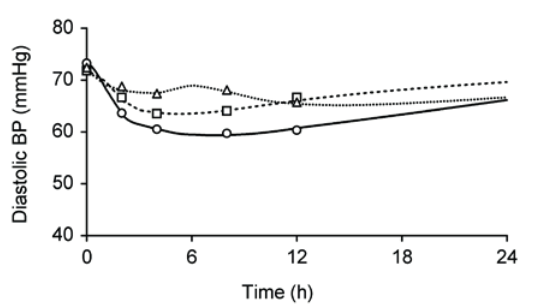
Figure 6. The PK/PD model solution of DP time profile related to measured atenolol (triangles), valsartan (squares) concentrations and their combination (circles). Table 6. The parameters of PD system for HR after separate and combined administration of atenolol and valsartan. Drug